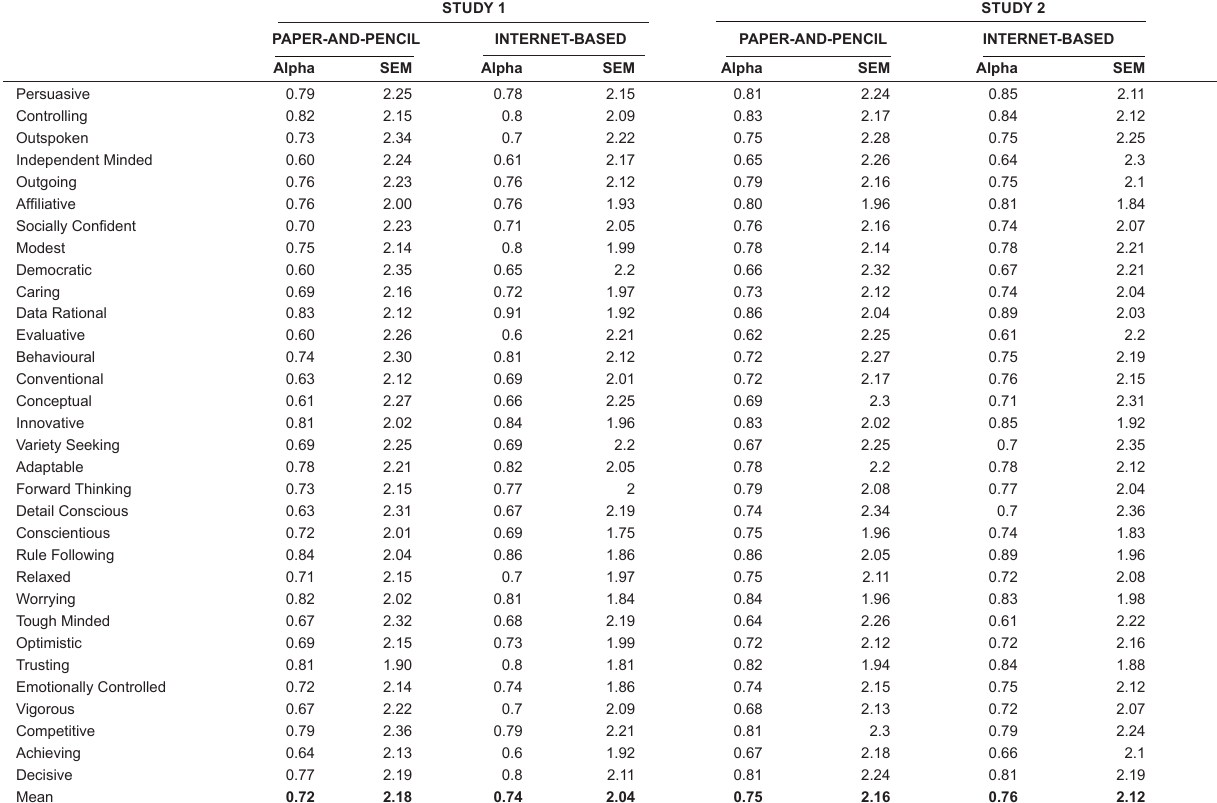
Table 3 Internal consistency reliabilities and standard errors of measurement for Studies 1 and